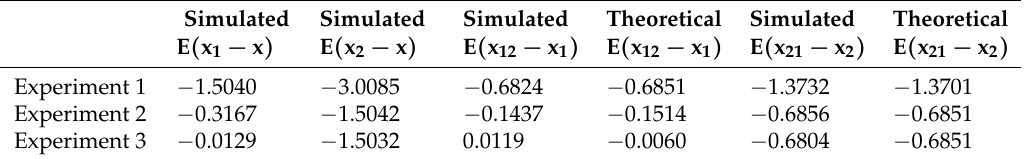
Table of XCO2 biases remaining after averaging kernel correction, based on 3000 simulations (Columns 3 and 5) and based on theoretical derivations (Columns 4 and 6). Units are in parts-per-million